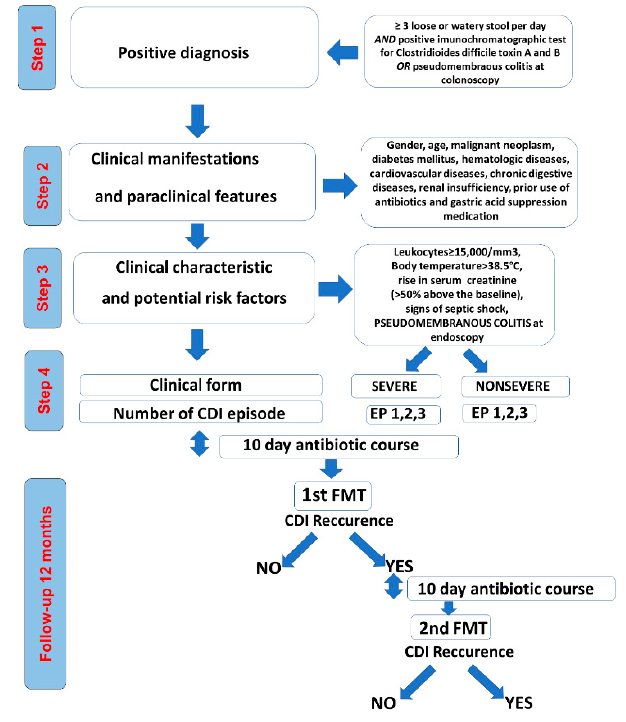
Figure 1. Study design. Figure 1.